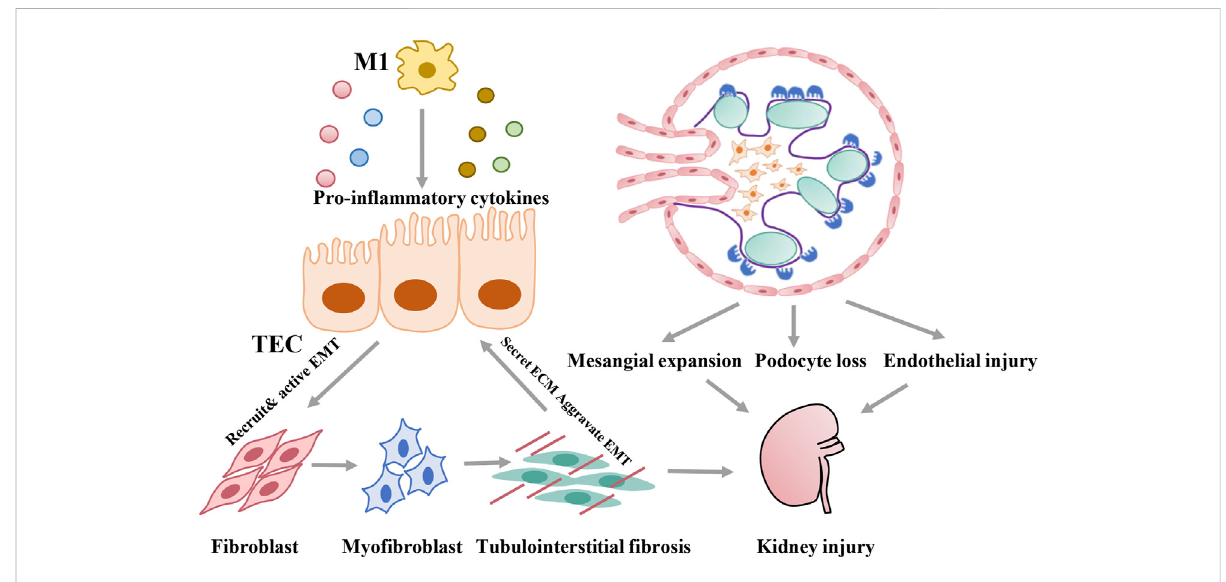
FIGURE 2 Pathological damage induced by metabolic reprogramming of different cells during development of